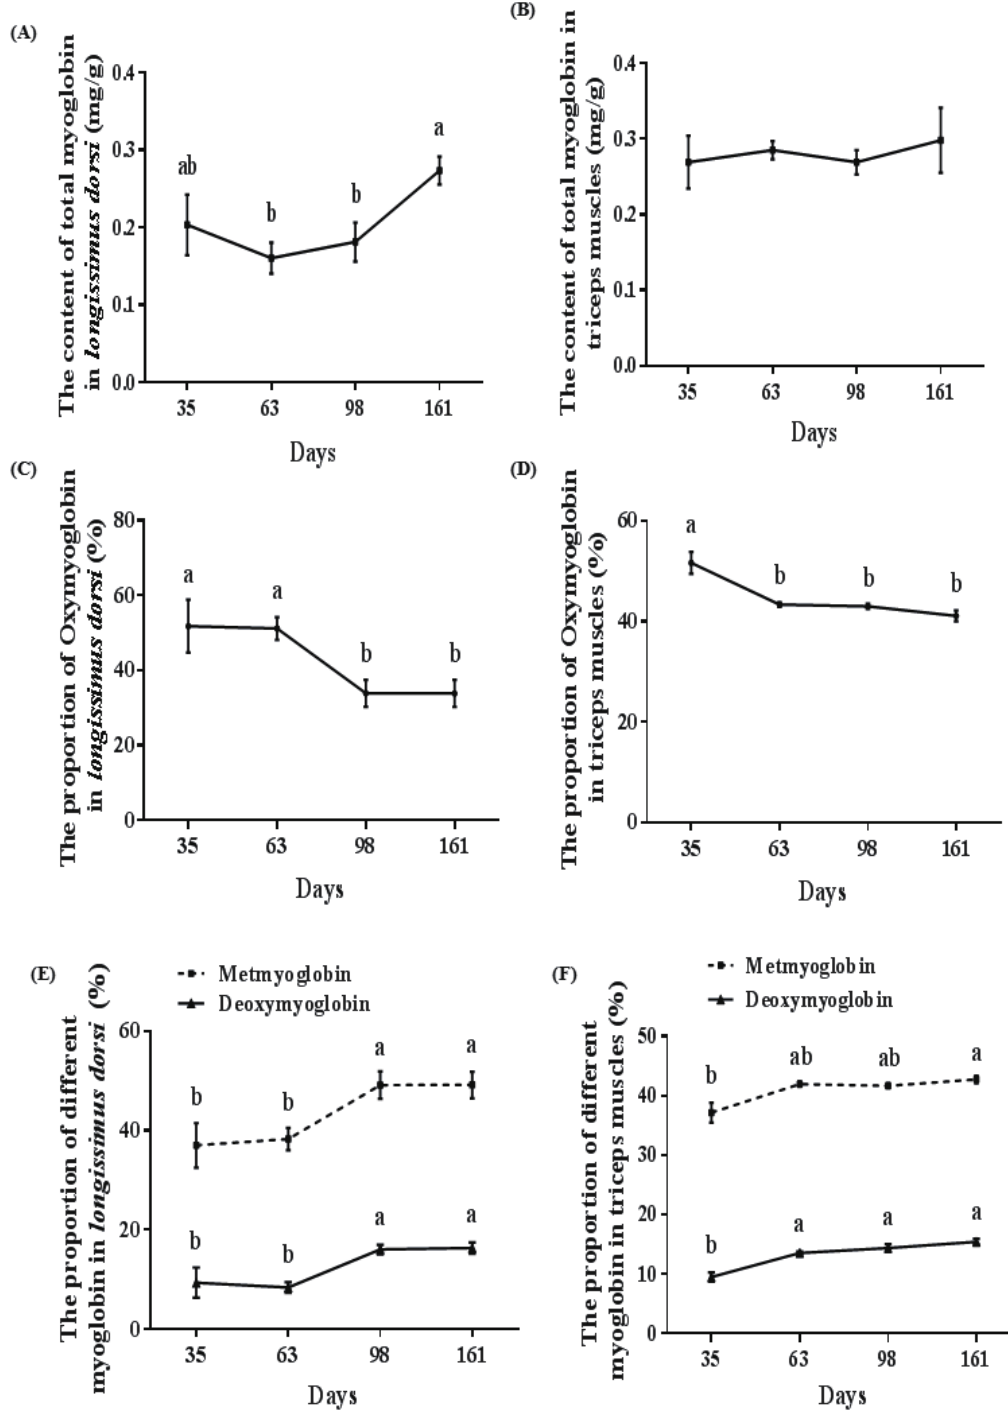
Figure 2. Changes of myoglobin content in porcine skeletal muscle at different stages of growth. (A, B) Total myoglobin content in longissimus dorsi and triceps muscles, respectively. (C, D) Proportion of oxymyoglobin in longissimus dorsi and triceps muscles, respectively. (E) Proportion of metmyoglobin and deoxymyoglobin in longissimus dorsi. (F) Proportion of metmyoglobin and deoxymyoglobin in triceps muscles. Mean with different superscripts demonstrate significant difference among groups (p<0.05), n =